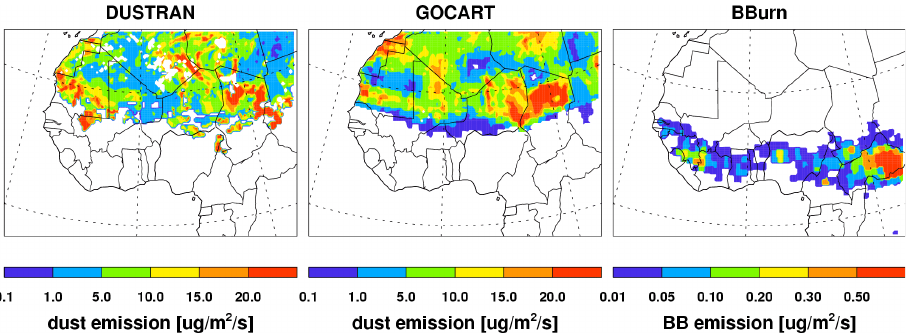
Fig. 3. Dust emissions from the DUSTRAN and GOCART dust schemes and biomass burning emissions (OC+BC) from the GFEDv2 inventory for the simulation period (6 January–5 February 2006) over North Africa. “BBurn” represents biomass Figure 3 Dust emissions from the DUSTRAN and GOCART dust schemes and biomass 8 burning emissions (OC+BC) from the GFEDv2 inventory for the simulation period 9 (January 6 th -February 5 th of 2006) over North Africa. “BBurn” represents biomass 10 burning. 11